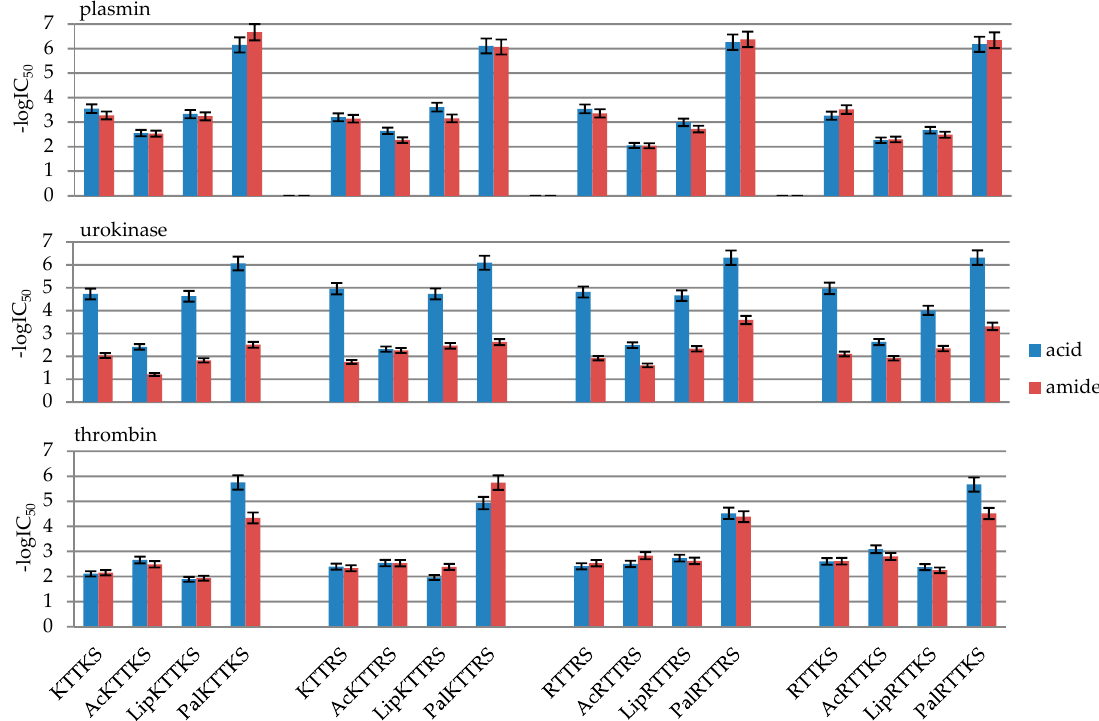
Figure 5. Influence of peptides in the form of C-terminal acids and amides on plasmin, urokinase and thrombin activity. Inhibition values in the form of -logIC 50 from Table 3.